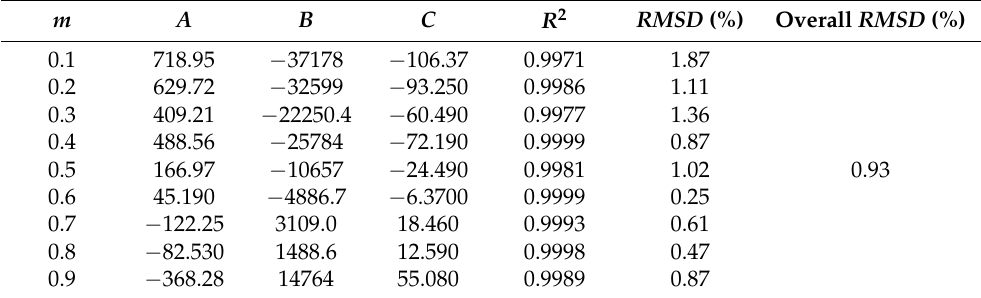
Figure 7. The correlation of ln x e values of TRV with the modified Apelblat model in various PG + water compositions as a function of 1/ T ; symbols represent the experimental solubilities of TRV, and solid lines represent the solubilities of TRV calculated using the modified Apelblat model. Table 5. The results of the Apelblat model for TRV in various PG + water